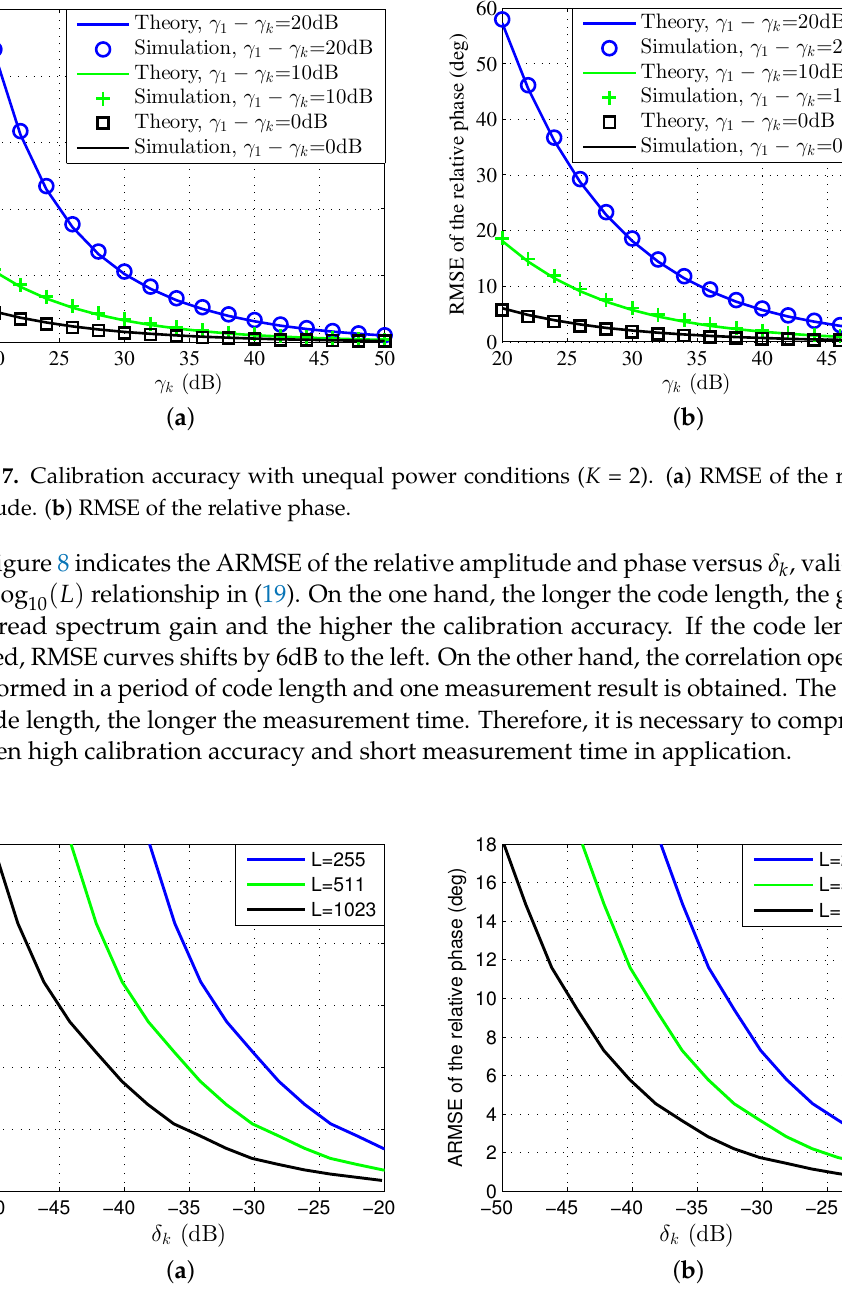
Figure 8. Calibration accuracy with different code lengths ( K = 10). ( a ) RMSE of the relative amplitude. ( b ) RMSE of the relative